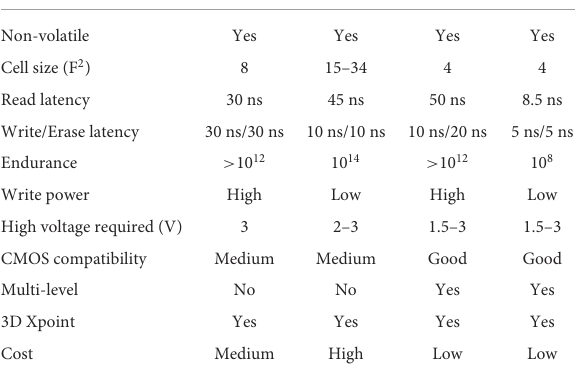
TABLE 2 The performance comparison of post-silicon nano-electronic device (Lai and Lowrey, 2001; Song et al., 2008; Sheu et al., 2009; Kim et al., 2011; Tamura et al., 2011; Bez and Cappelletti, 2012; Bez et al., 2013; Zangeneh and Joshi, 2014; Roy et al., 2020; Saxena,